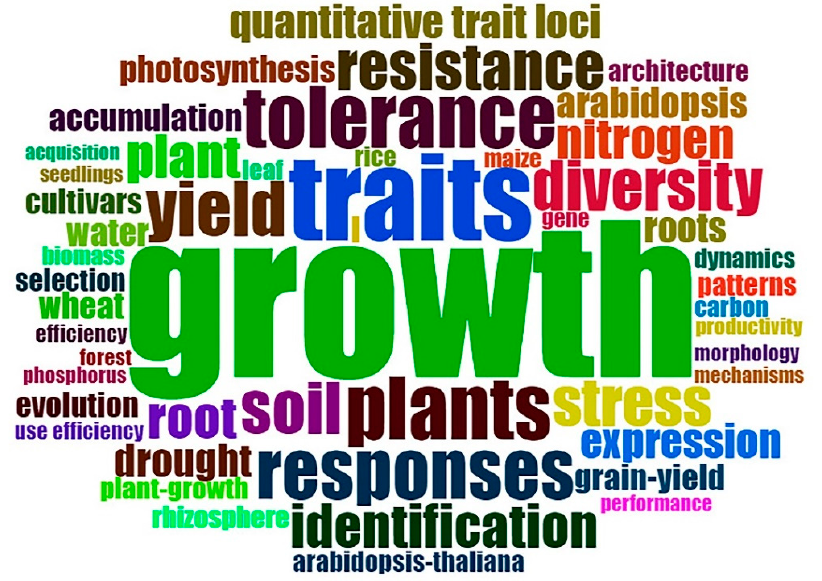
Figure 7. The top 50 keywords mentioned in root traits research from 2000 to 2021 .